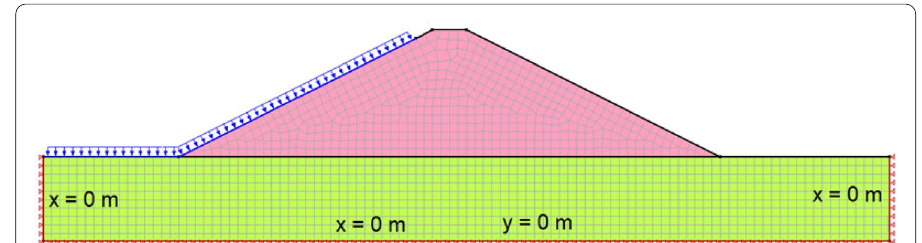
Fig. 4 A typical of the homogeneous earthen dam with different boundary conditions as applied for Sigma/W